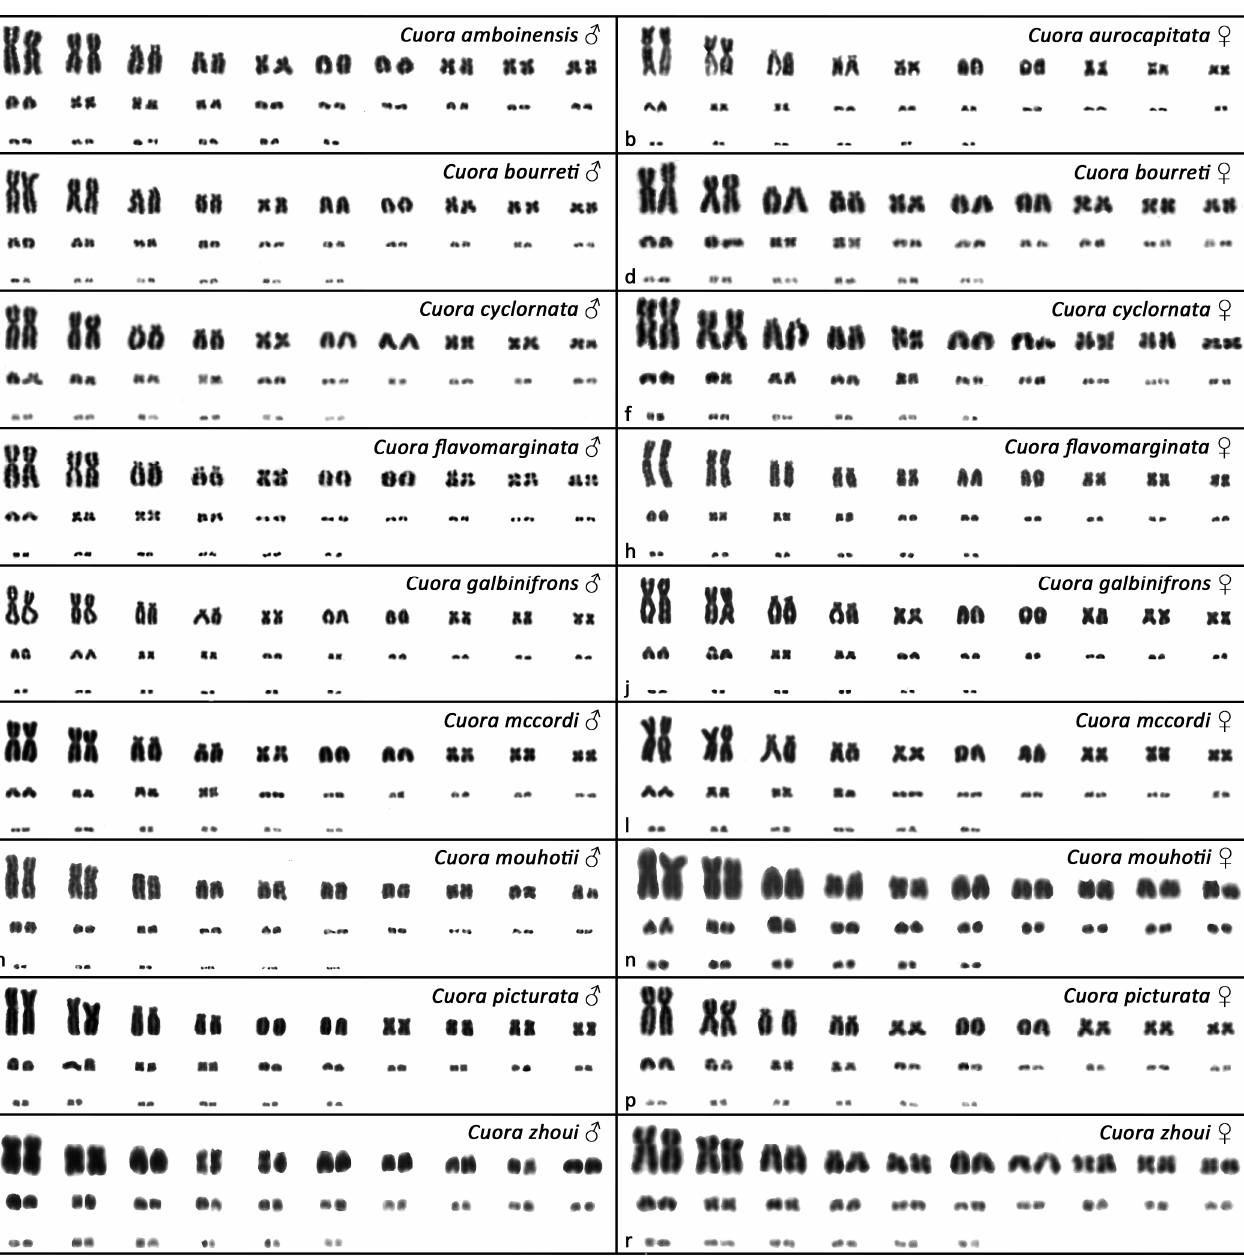
Figure 1. Karyograms from Giemsa-stained metaphases of Cuora amboinensis ( a ), Cuora aurocapitata ( b ), Cuora bourreti ( c , d ), Cuora cyclornata ( e , f ), Cuora flavomarginata ( g , h ), Cuora galbinifrons ( i , j ), Cuora mccordi ( k , l ), Cuora mouhotii ( m , n ), Cuora picturata ( o , p ), and Cuora zhoui ( q , r ).